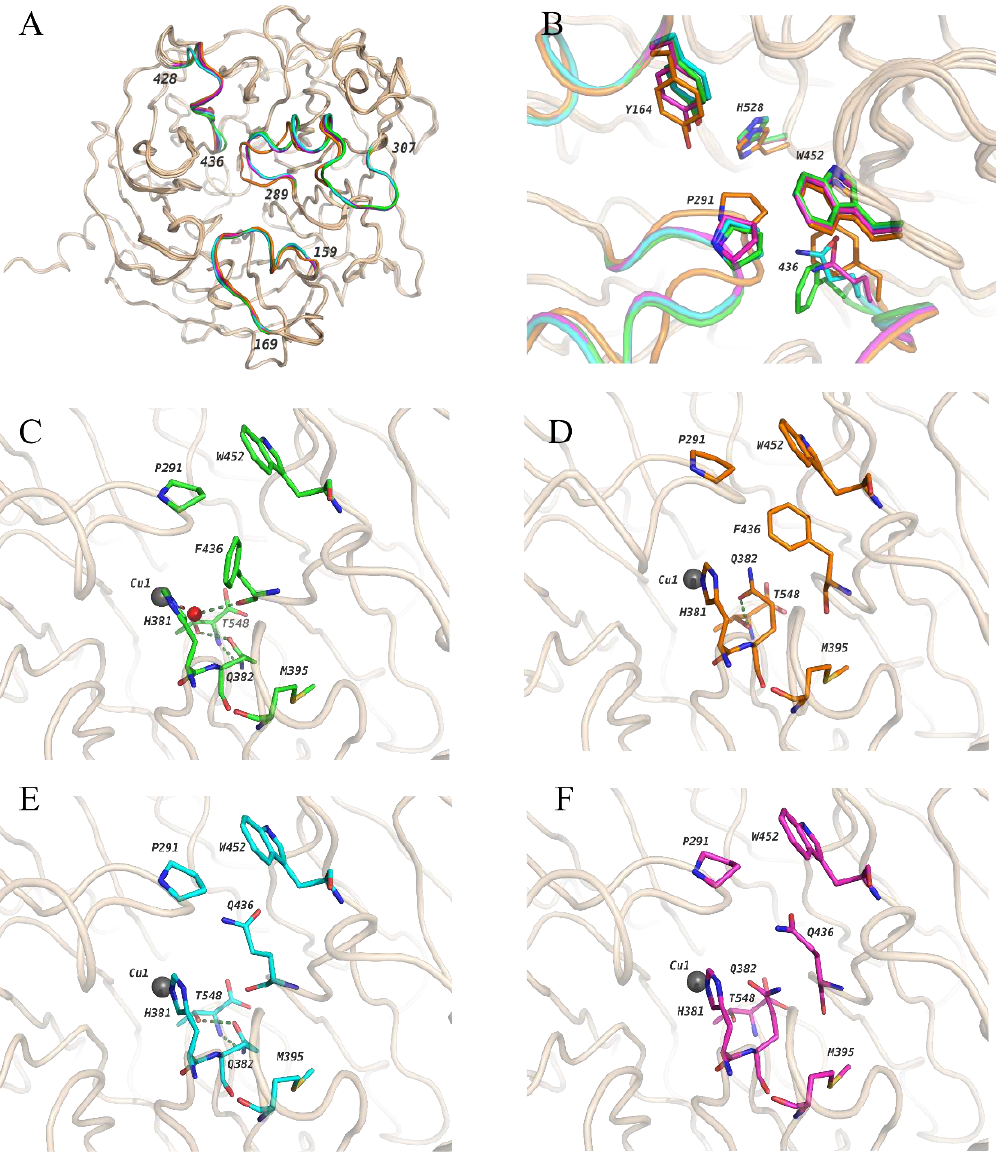
Figure 3. ( A ) The superposition of TcDH F436Q as well as the open (PDB ID6I3Q) and closed form (PDB ID 6UWE) of TcDH. Matching regions of polypeptide chains are shown in beige, mobile loops of TcDH F436Q internal and external subunits and open and closed forms of the TcDH (WT) are shown in magenta, cyan, green, and orange, respectively. Copper ions are presented in gray spheres. ( B ) The position of P291 residue as “closing lid” in structure of internal (magenta) and external (cyan) subunits of TcDH F436Q , the open form (green) and the closed form (orange). The conformation of Q382 and 436 residues in the active center: ( C ) the open form (green) of TcDH (WT); ( D ) the closed form (orange) of TcDH (WT); ( E ) the external (cyan) subunit of TcDH F436Q ; ( F ) the internal (magenta) subunit of TcDH F436Q . The green dashed lines on panels ( C – E ) demonstrate hydrogen bonds. Copper ion and solvent molecule are presented in gray and red spheres, respec- tively.